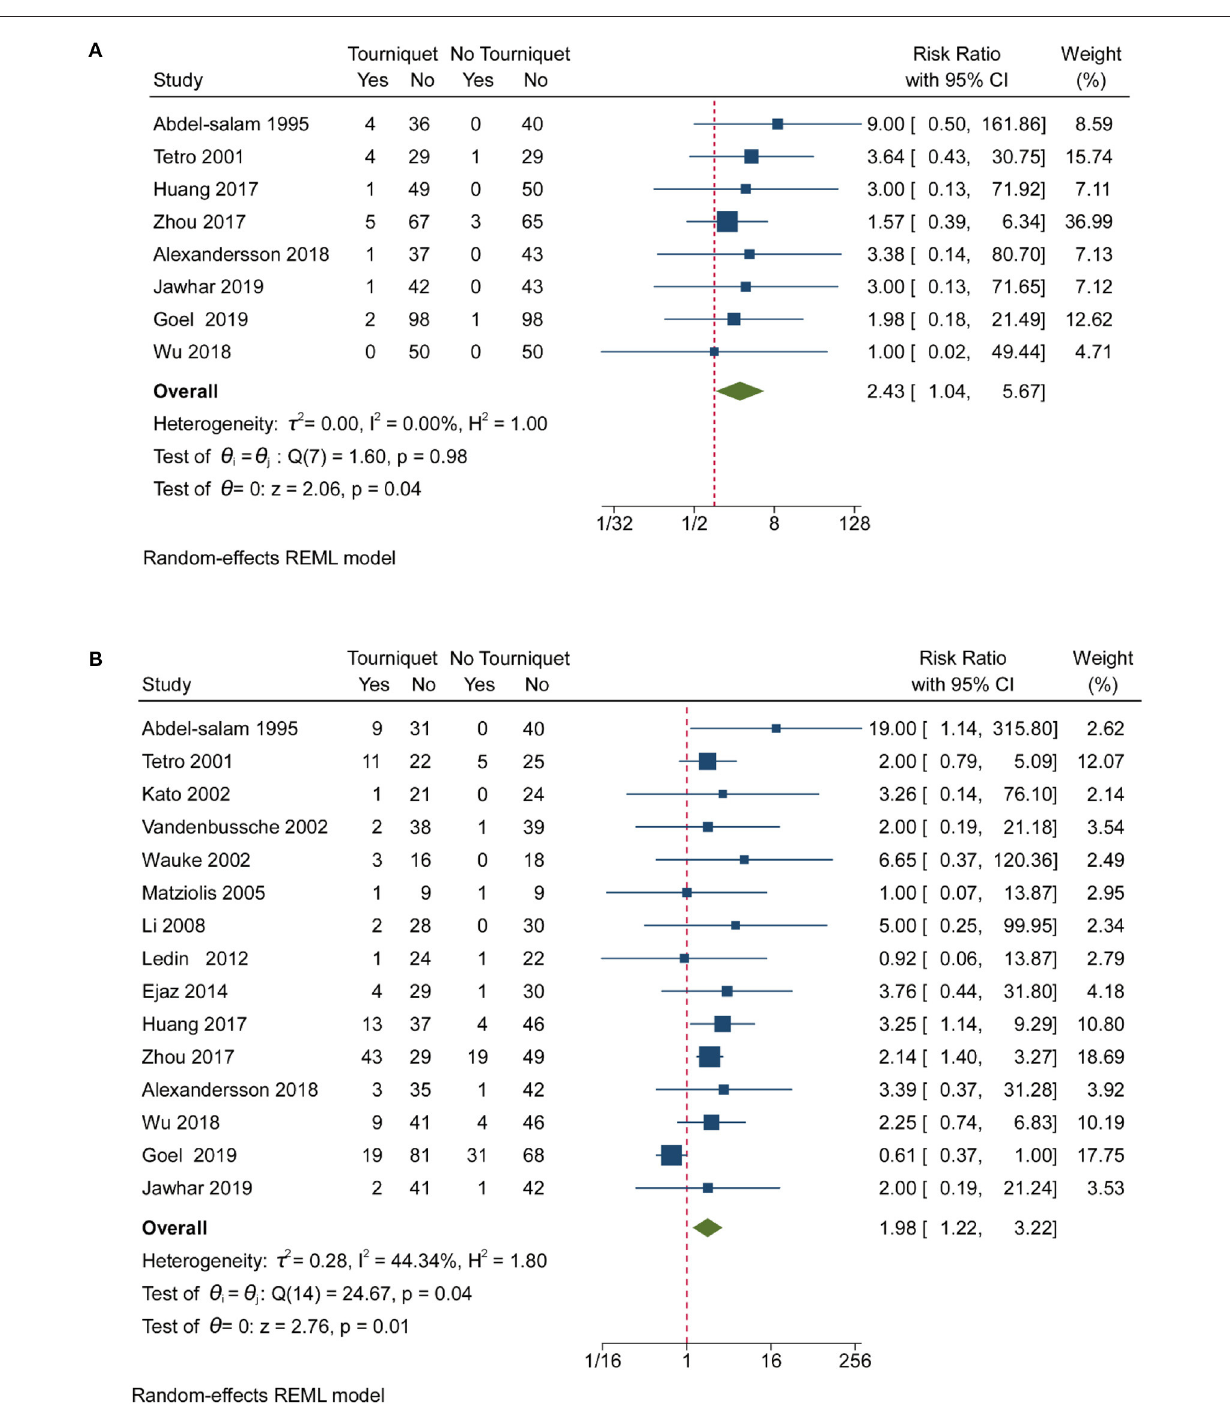
FIGURE 5 | Forest plot for superficial wound infection and all complication rates. (A) Forest plot comparing superficial wound infection rates between the no tourniquet and tourniquet groups; (B) Forest plot comparing all complication rates between the no tourniquet and tourniquet groups. all software and website sources. Third, analyses were